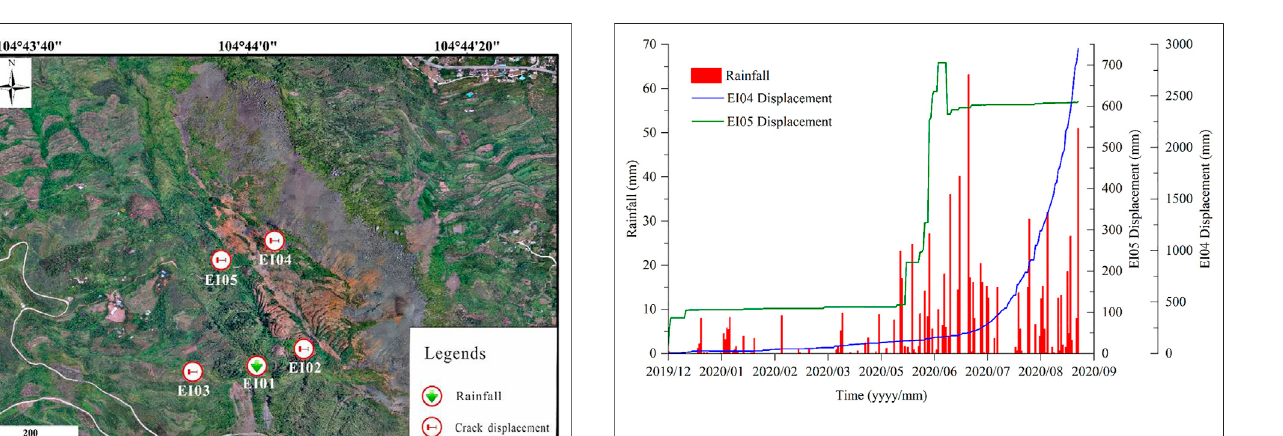
FIGURE13| Comprehensiveanalysiscurveofrainfallanddisplacement.